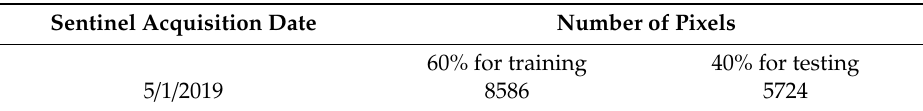
Table 3. Number of pixels for training and testing at various acquisition